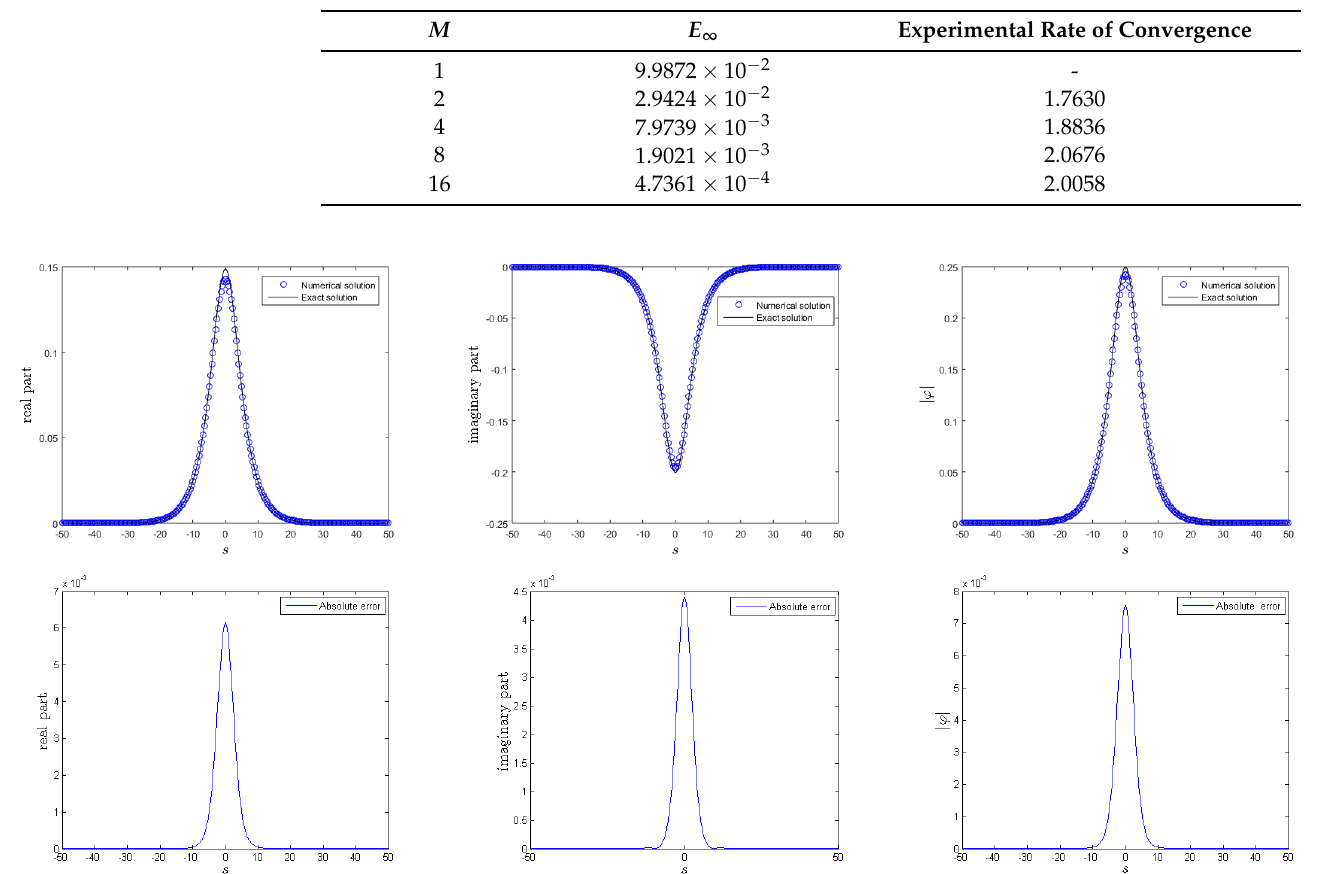
Table 5. The numerical results at ∆ τ = 0.0001, and T = 1 for Test Problem 2. Theoretical rate of convergence is 2 (see Theorem 1).